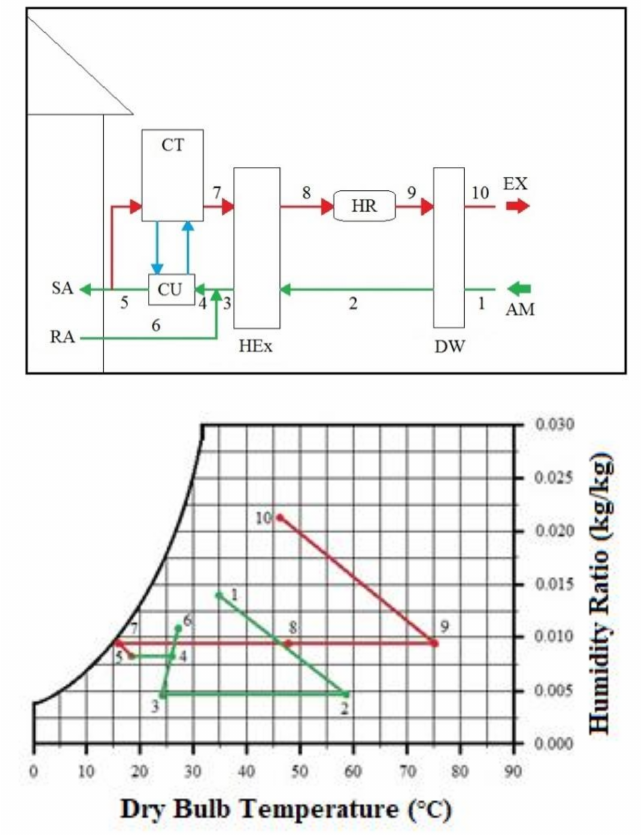
Figure 7. REVERS